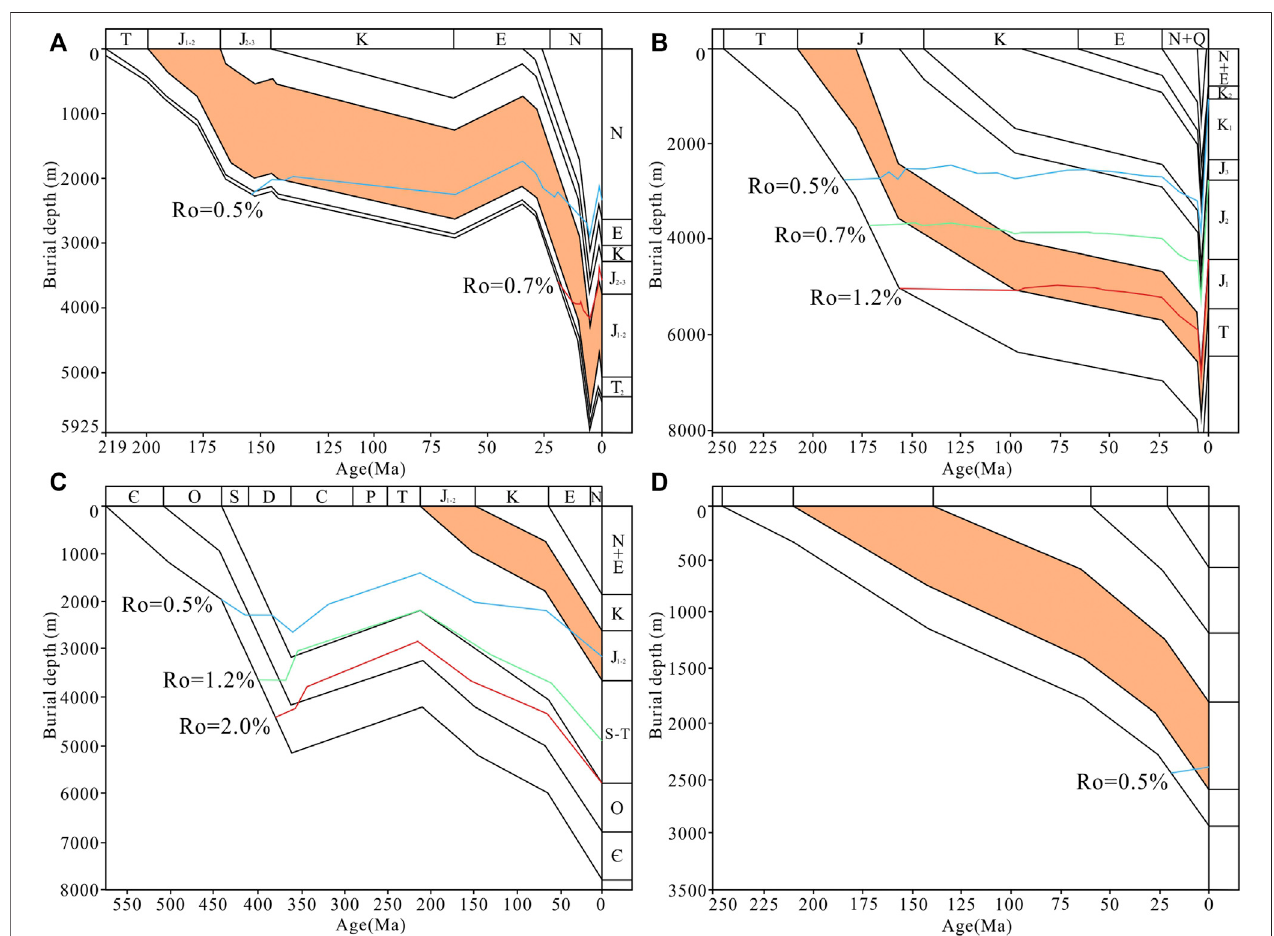
FIGURE8|(A) BurialhistoryofJurassicshaleinYinan2well,KuqaDepression. (B) BurialhistoryofMesozoicshaleinKuzigongsusection,SouthwestTarimBasin. (C) Burial history of Mesozoic shale in Cao7 well, Northeastern Tarim Basin. (D) Burial history of Mesozoic shale in the Southeastern Tarim Basin.